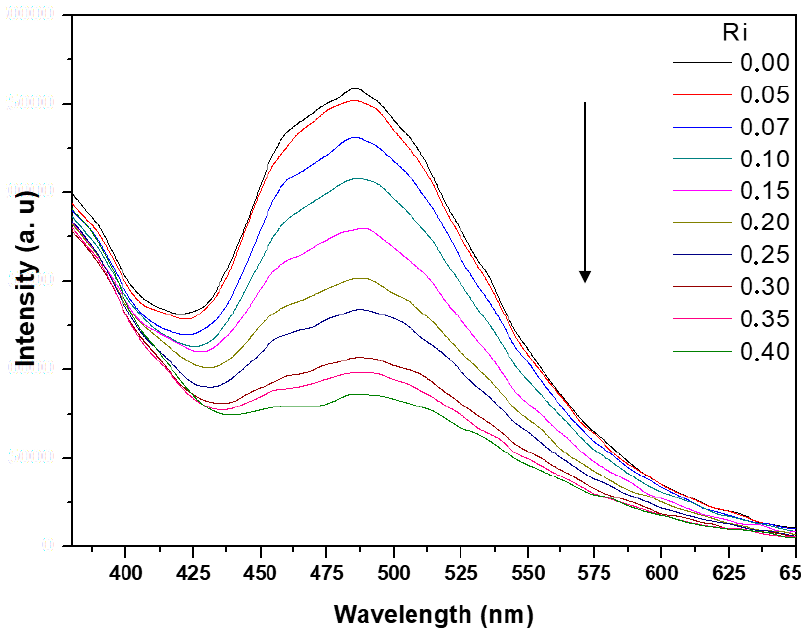
Figure 1. Hoechst 33258 (H33258) displacement assay for metal complex